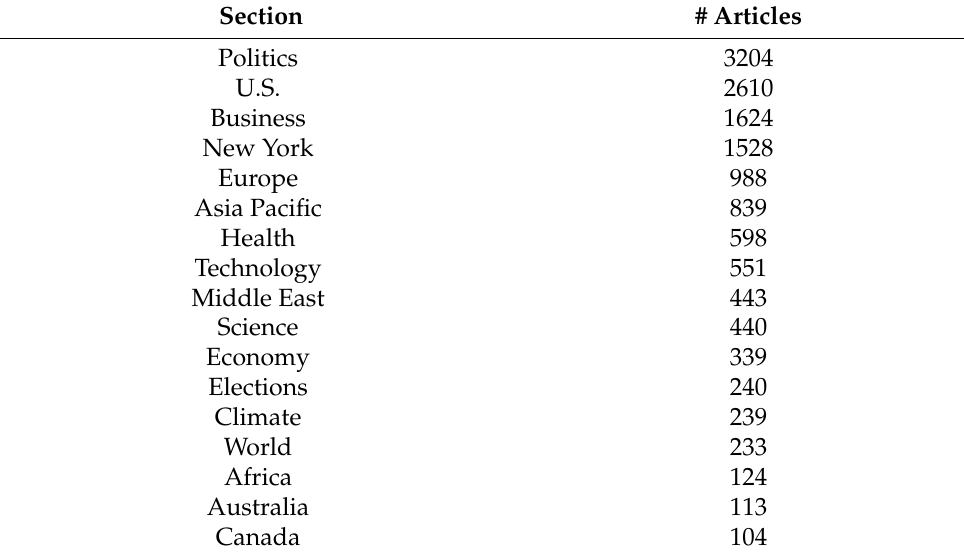
Table 2. New York Times news corpus composition by section and number of articles.